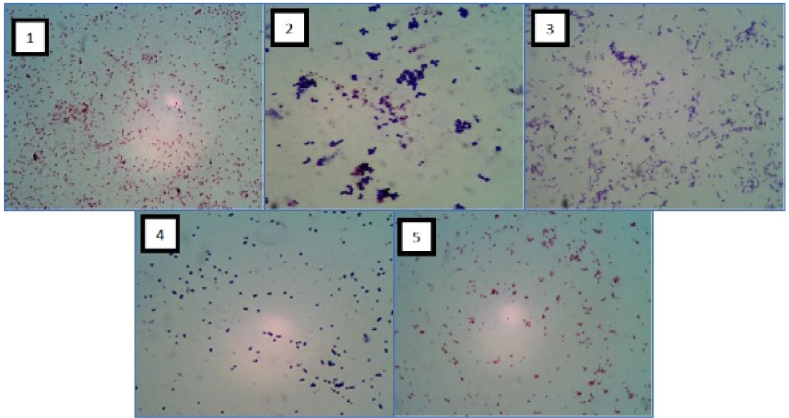
Figure 2. Gram stain of the bacterial